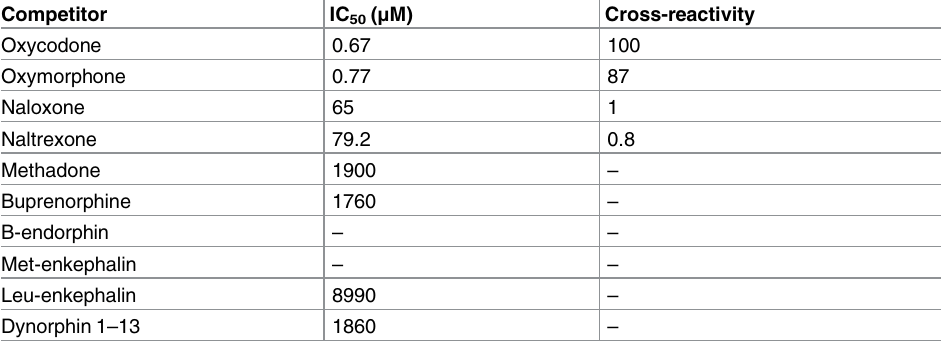
Table 1. Relative affinities of antibodies generatedby vaccination of rats with OXY-dKLH as mea- sured by IC 50 values in competitive